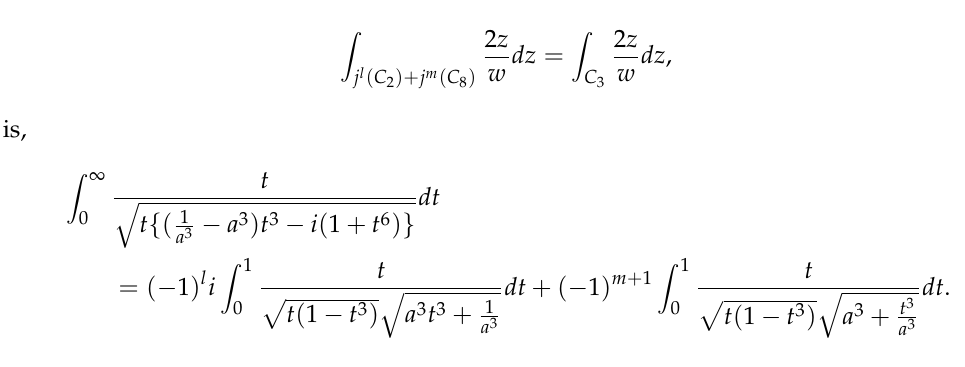
Figure A14. C 3 in (i).